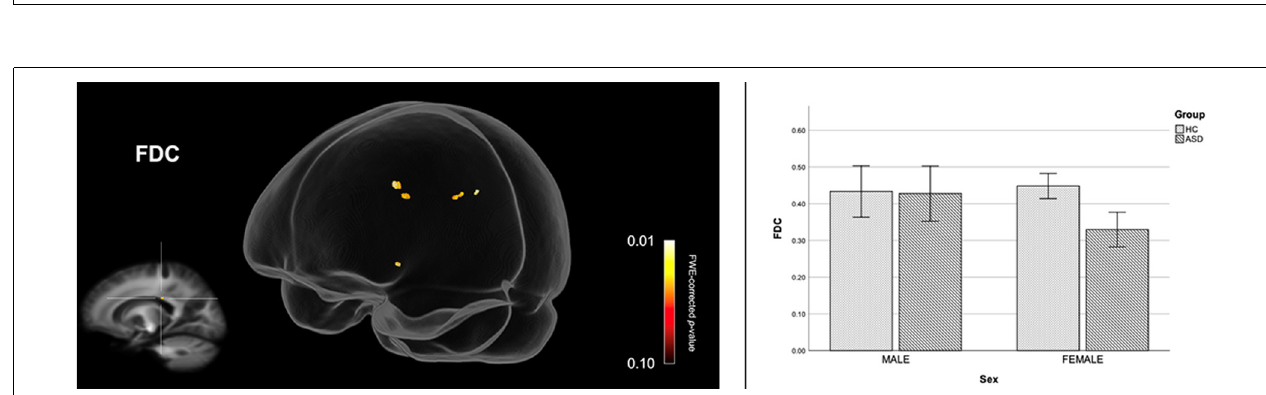
FIGURE 1 | Fiber specific tract reductions in fiber density (FD) in the ASD group (compared to the control group). Streamline segments were cropped from the whole brain tractogram to include only streamlines that traversed fixels showing a trend towards reduced fiber density in the ASD group ( p < 0.10, FWE corrected). No significant differences were observed at p < 0.05, FWE corrected. FWE = Family-wise error.